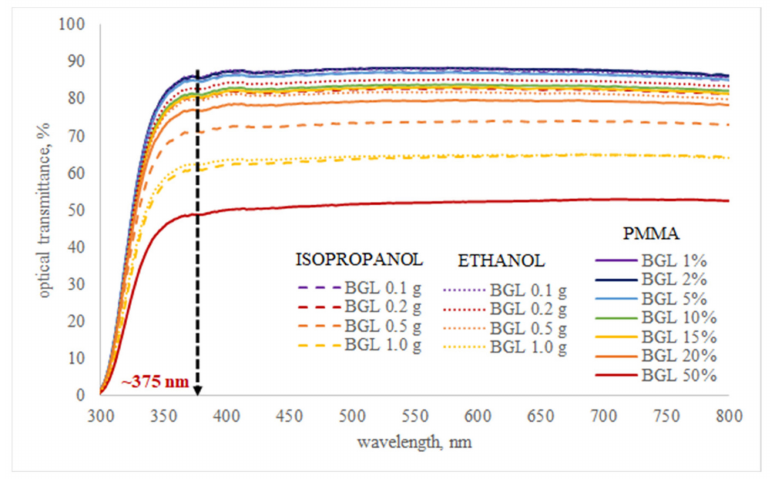
Figure 3. The optical transmittance characteristic of layers prepared with spray-coating method based on BGL pigment in all three